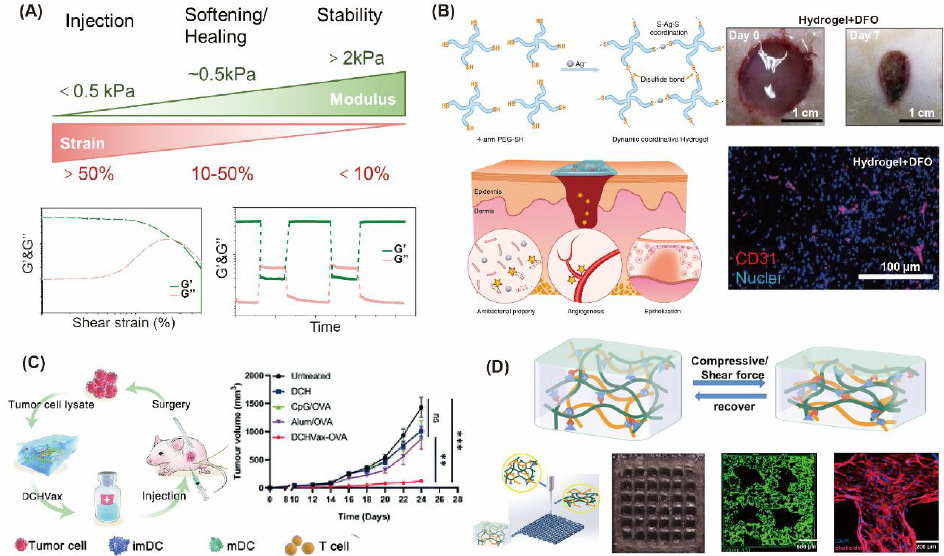
Figure 7. Applications of injectable dynamic covalent hydrogels. ( A ) typical rheological behaviors of injectable hydrogels. ( B ) Hydrogel containing dynamic nature of Ag-S coordination bond has injectable and self-healing properties. After loading DFO, hydrogels can realize angiogenic properties for diabetic wound regeneration[86]. ( C ) Subcutaneous injection of dynamic covalent hydrogel- based vaccine (DCHVax) recruits dendritic cells to the matrix in situ and elicits robust tumor-specific immune responses [142].(ns: not significant, * p < 0.05, ** p < 0.01, *** p < 0.001) ( D ) A double-network (DN) hydrogel based on dynamic hydrazone-crosslinked hyaluronic acid (HA-HYD) photocrosslinked gelatin methacrylate (GelMA), which was suitable for extrusion-based 3D printing, in which BMSCs could proliferate well [144].